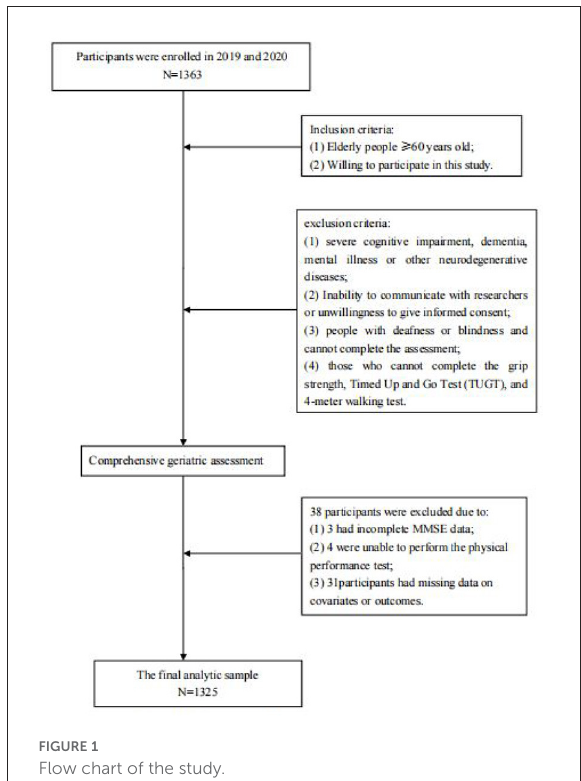
FIGURE1 Flow chart of the study.